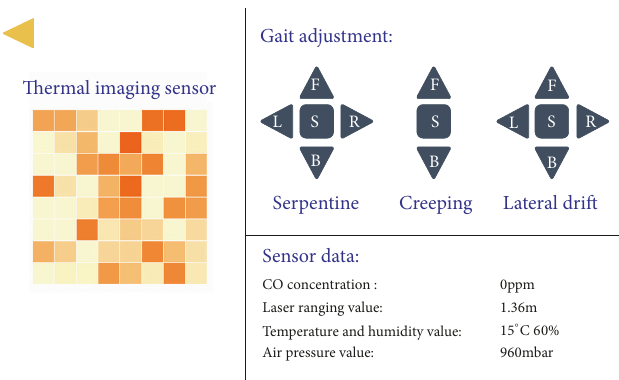
Figure 18: Sensors information display